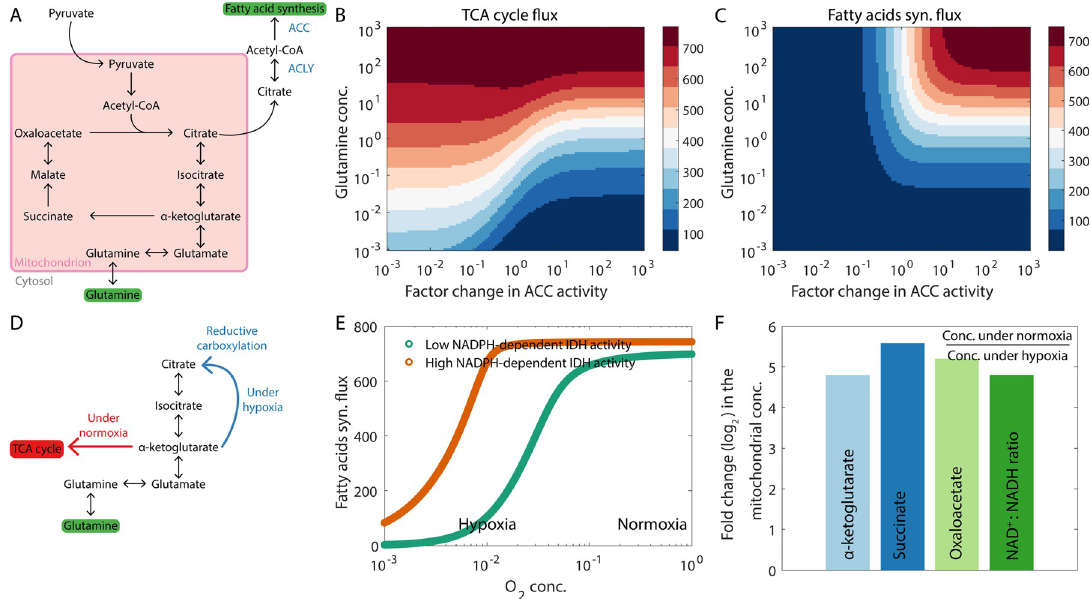
Fig 3. Glutamine is a key metabolite for anaplerosis during de novo fatty acid synthesis and can be utilized via different pathways under different conditions. (A) Reactions in the TCA cycle. The citrate removed from the TCA cycle for use as a substrate for fatty acid synthesis is replenished by the α -ketoglutarate generated from glutamine. (B) At high rates of de novo fatty acid synthesis (indicated by high ACC activity), our model predicts that the TCA cycle will shut down at low glutamine concentrations. Here, the flux through the enzyme α -ketoglutarate dehydrogenase is shown as the TCA cycle flux. (C) High glutamine availability can drive a large fatty acid synthesis flux. (D) Glutamine can be utilized for fatty acid synthesis via distinct pathways under normoxic and hypoxic conditions. (E) Under hypoxic conditions, glutamine can be utilized via the reductive carboxylation pathway (see panel D). High activity of NADPH- dependent IDH is essential for reductive carboxylation. (F) Ratio of the concentration of different TCA cycle intermediates under normoxic conditions to the concentration under hypoxic conditions. The panel also shows the ratio of the mitochondrial NAD + :NADH ratios under the two conditions. Since the NADPH-dependent IDH pathway (active under hypoxic conditions) skips the TCA cycle reactions, activation of this pathway is accompanied by a decrease in the mitochondrial concentrations of multiple TCA cycle intermediates. Fluxes are in units of mM h -1 (millimolar per hour) and are shown at steady